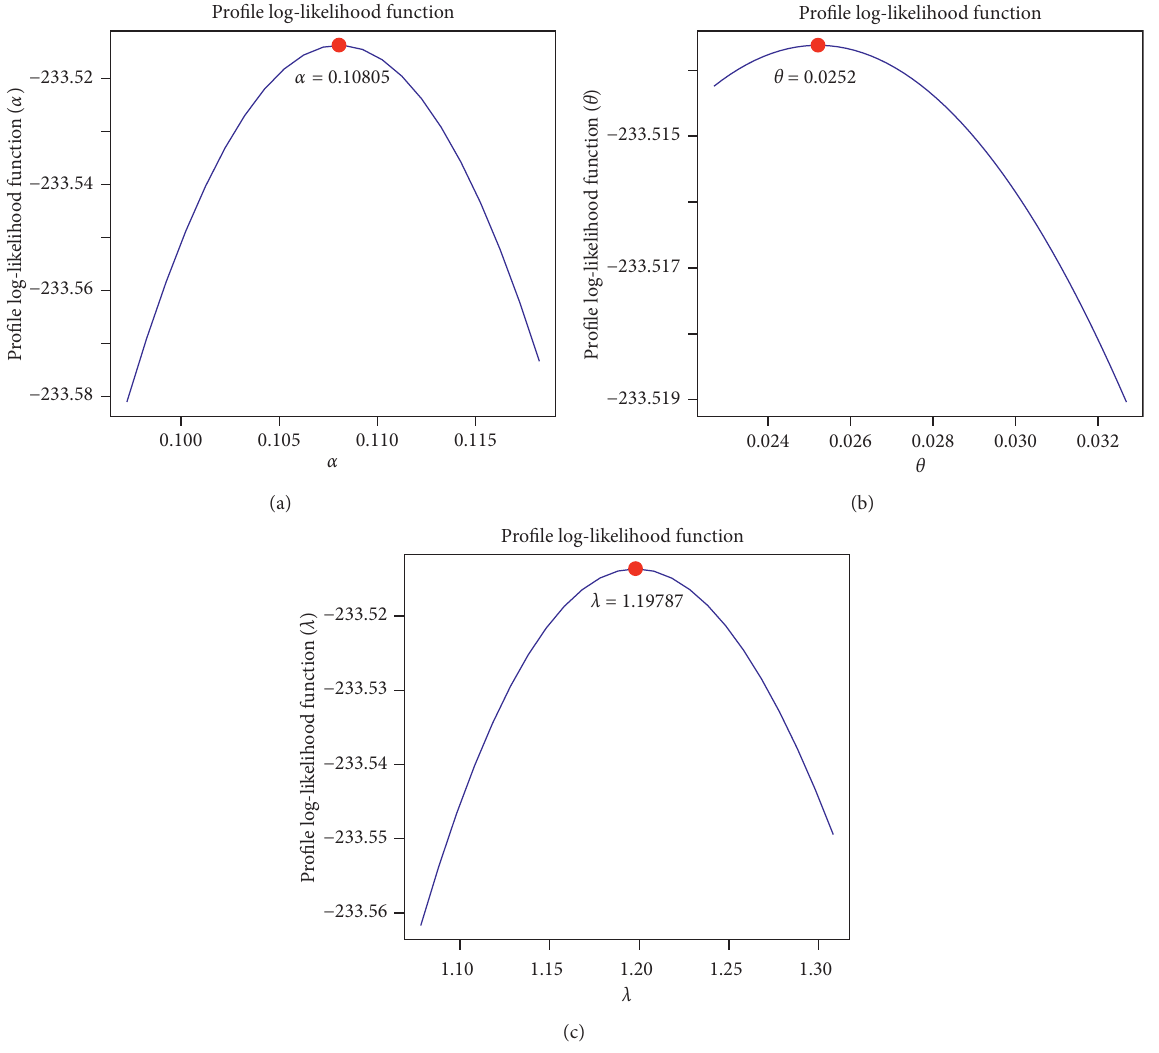
Figure 10: The profile of the log-likelihood function for lifetimes